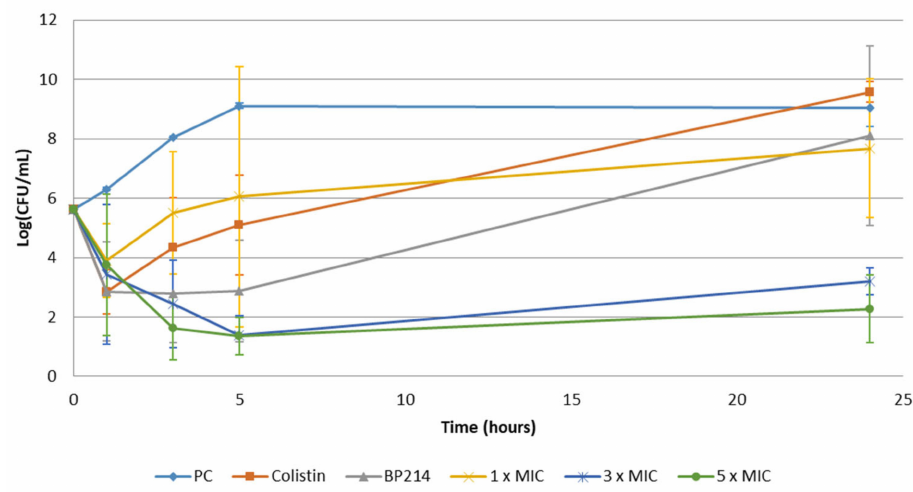
Figure 2. Time-kill kinetics of analogue 13 against E. coli . The following compounds were tested: Colistin; 1 × MIC, BP214; 1 × MIC, and 13 ; 1 × MIC, 3 × MIC and 5 × MIC. In addition, a positive control (PC) was included. Samples were collected at time points = 0, 1, 3, 5, and 24 h (n = 3, mean × standard deviation) post